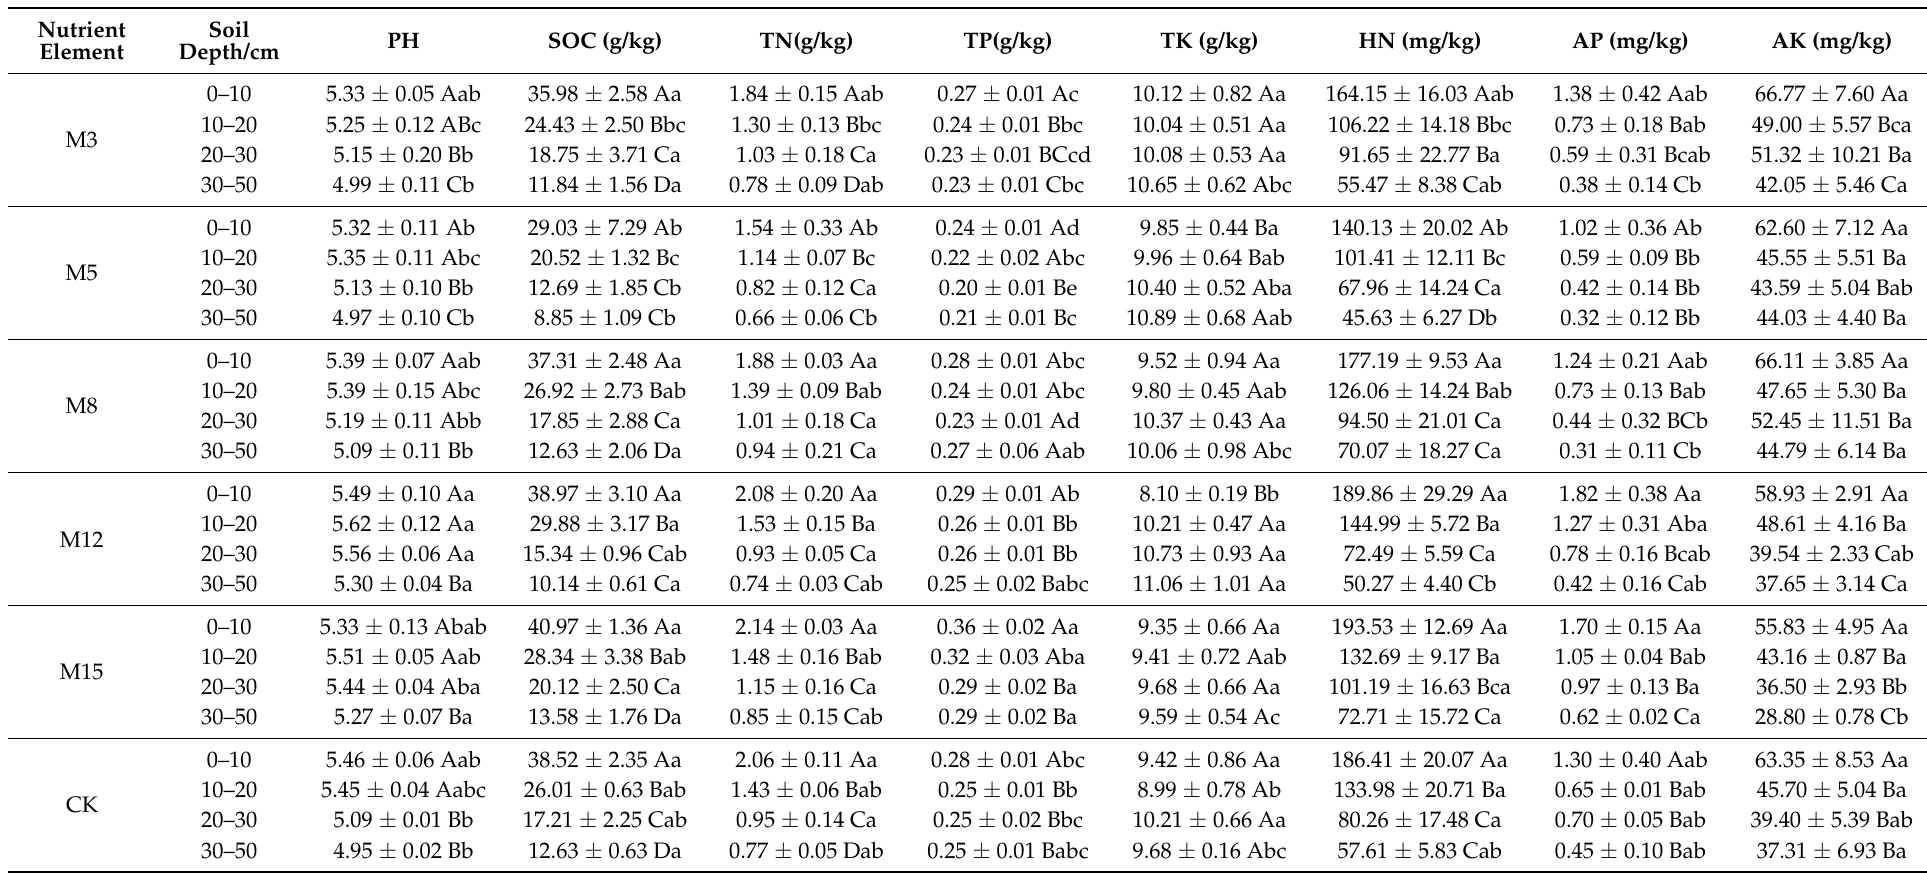
Table 2. Soil characteristics for moso bamboo in strip cutting (M3, M5, M8, M12, and M15) or unharvested (CK) plots. Nutrient